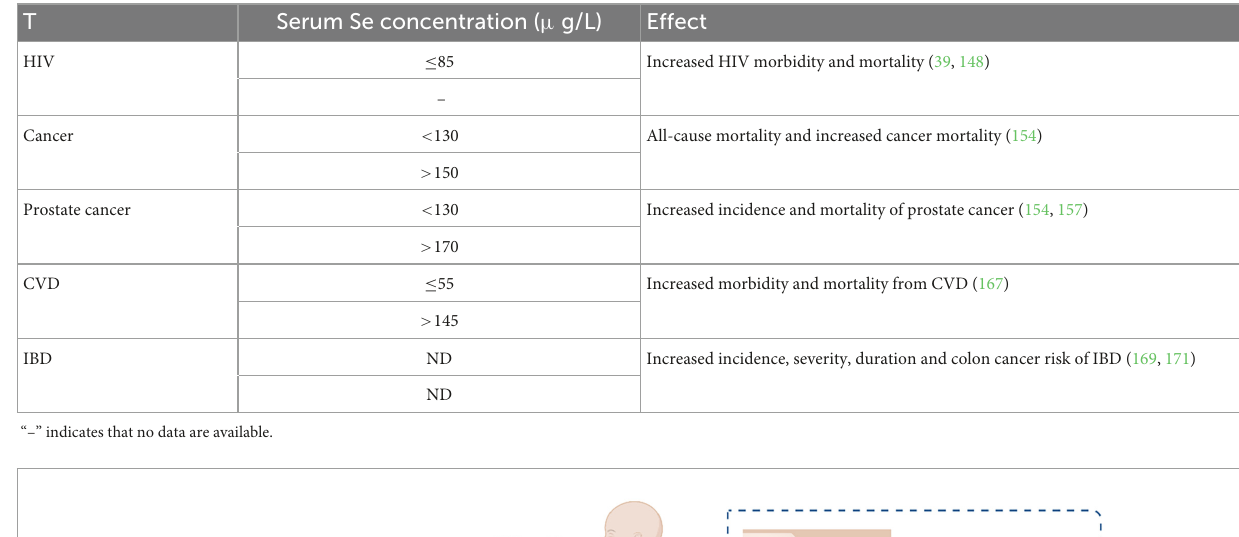
TABLE 2 Relationship between serum selenium status and disease risk.